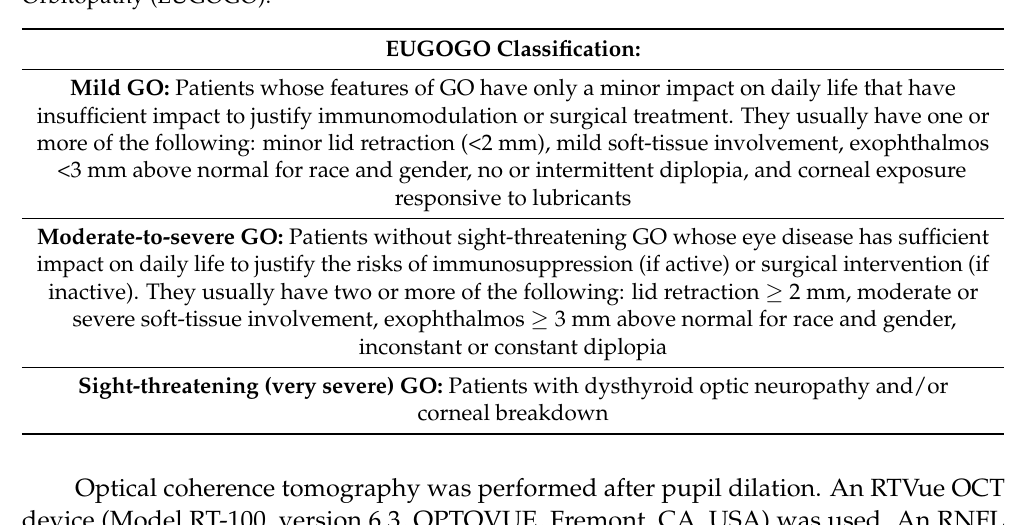
Table 1. Graves’ Orbitopathy (GO) severity assessment according to European Group on Graves’ Orbitopathy